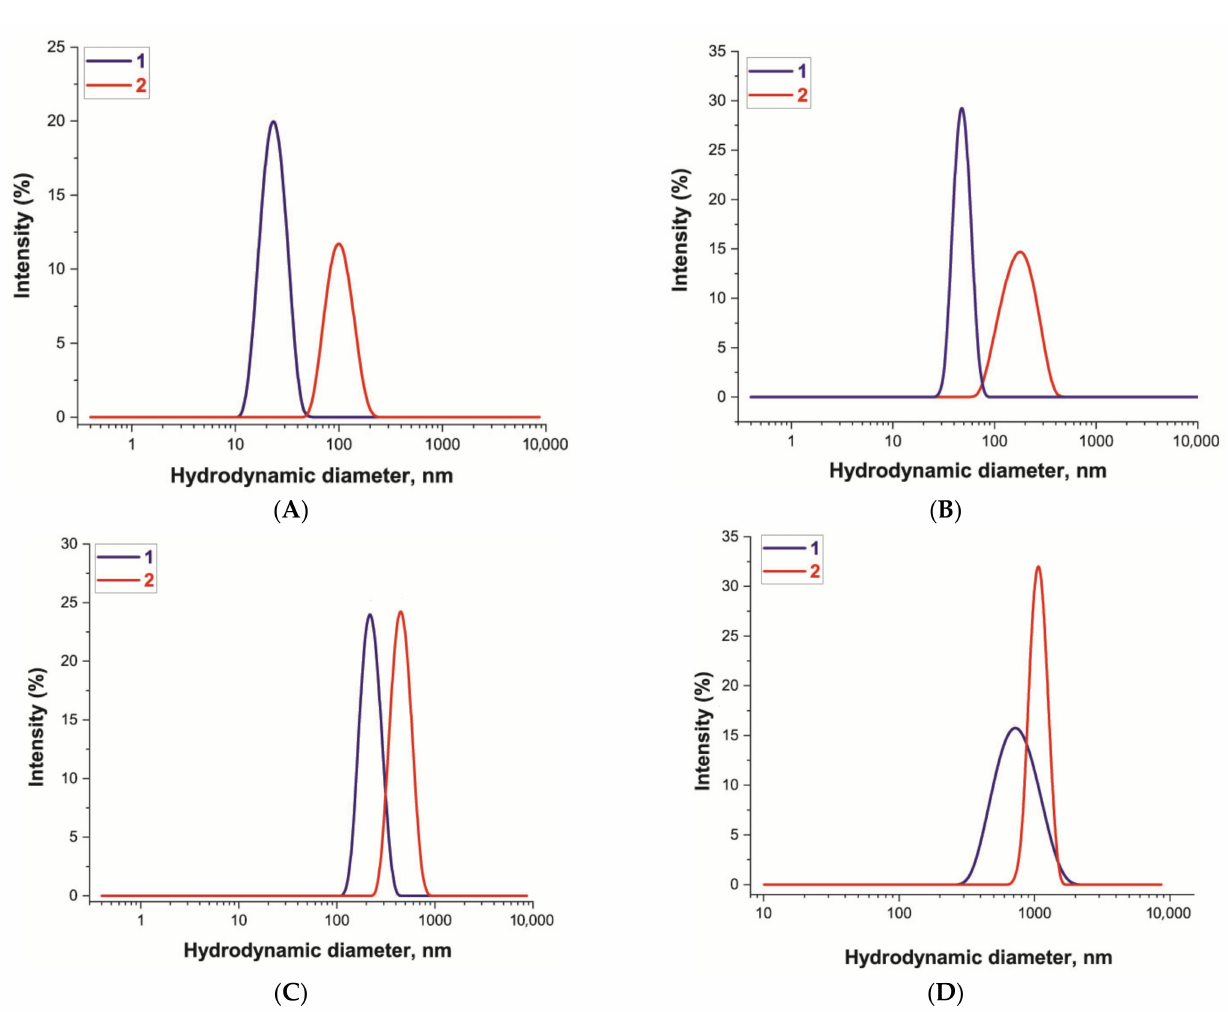
Figure 3. Distribution of hydrodynamic diameters of nanoparticles (1) and their conjugates with pAbs (2) obtained through DLS. ( A ) Au NPs, ( B ) Au@Pt NPs, ( C ) LPs, ( D )